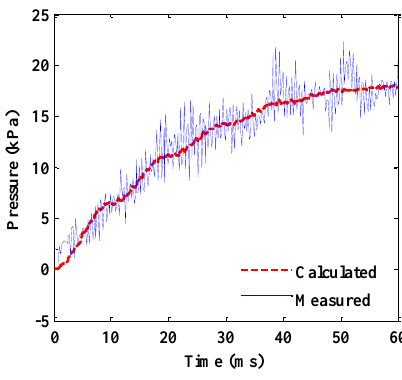
Figure 14. Pressure rise obtained by calculation and measurement.